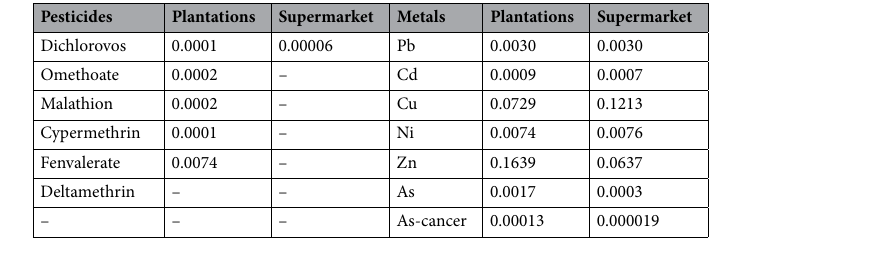
Table 2. Daily exposures to pesticides and metals in Goji berries (μg/[kg day]). – means not detected.